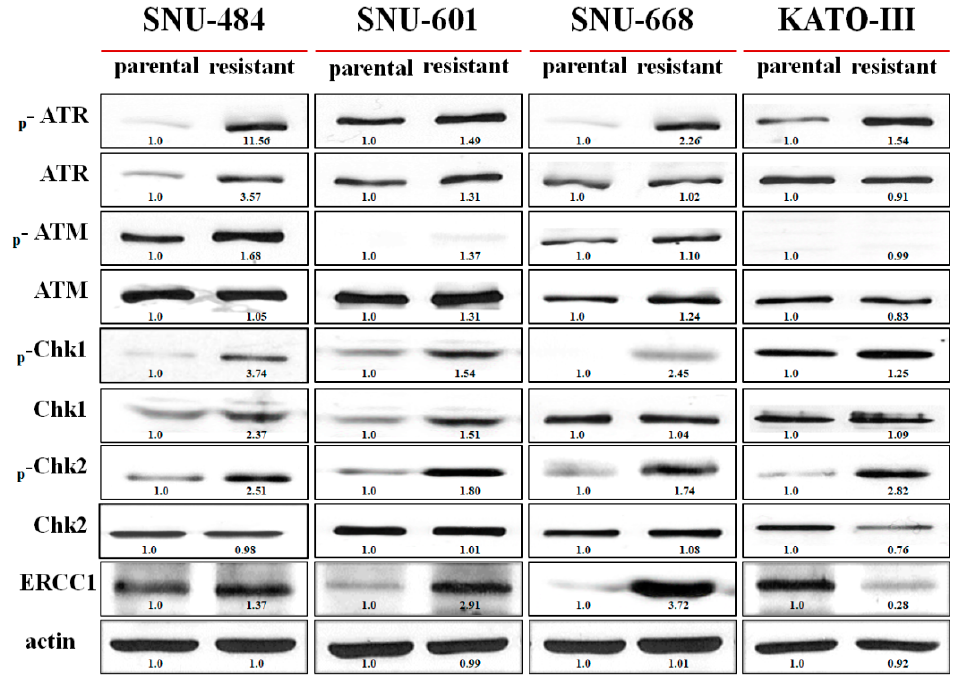
Figure 2. The expressions of DNA-damage response proteins were altered after acquisition of olaparib resistance. Western blot analysis for p-ATR, ATR, p-ATM, ATM, p-Chk1, Chk1, p-Chk2, Chk2, and ERCC1 was conducted to evaluate the altered expression after acquisition of resistance to olaparib. There were compensatory changes in the DNA-damage response proteins.